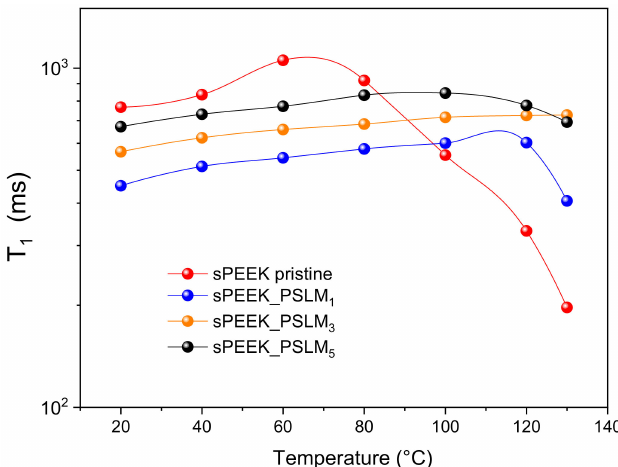
Figure 6. Spin-lattice relaxation times (T 1 ) as a function of the temperature (from 20 ◦ C to 130 ◦ C) of the water confined in sPEEK-based